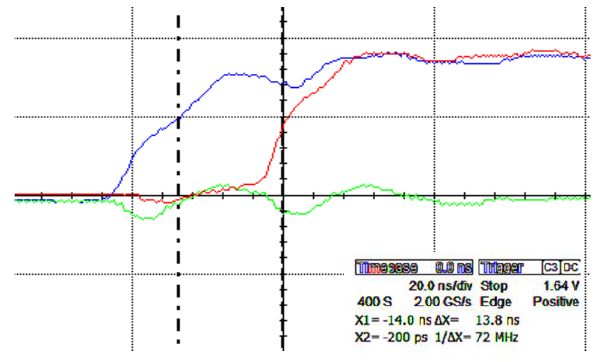
Fig. 2. Simulation results for the tested